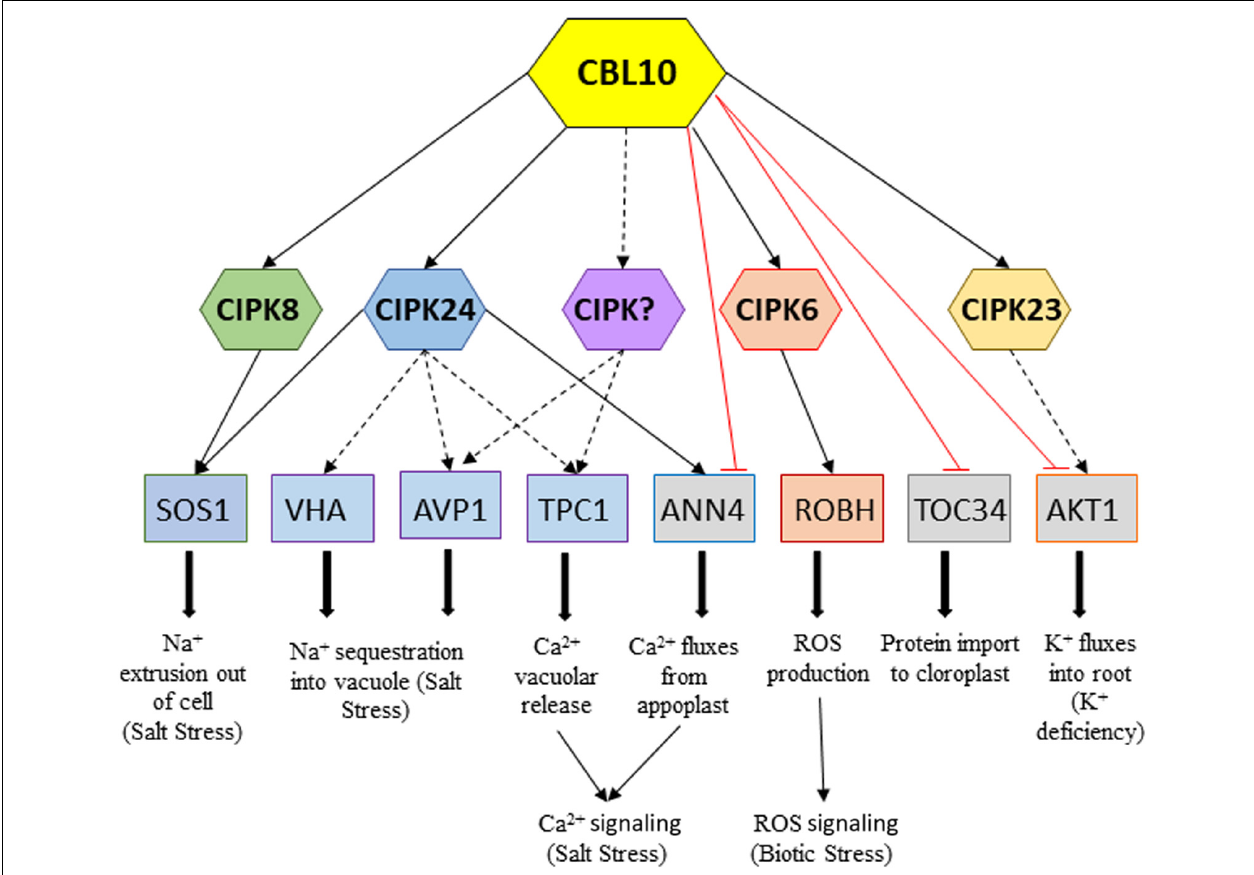
FIGURE 2 | Network of downstream CBL10–CIPKs interactions and CBL10 direct interactions activating or repressing targets in response to different stresses, respectively. Continuous black arrows indicate proved interaction and/or activation by phosphorylation; dotted black arrows indicate interactions still remain to be demonstrated, and red lines indicate demonstrated repressive